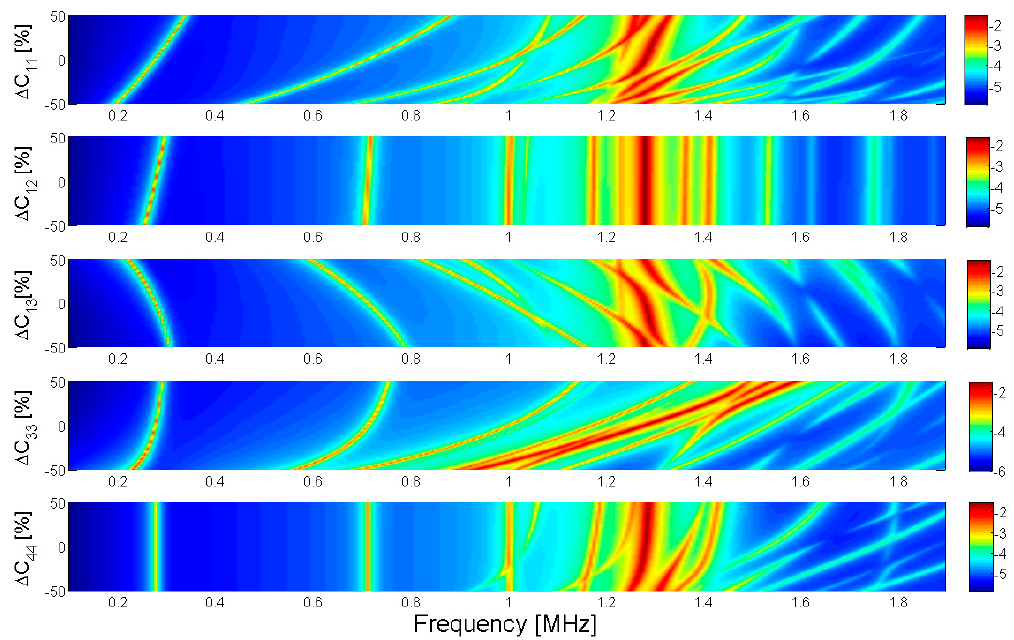
Figure 4. Sensitivity analysis for the real part of the elastic constants. Each curve shows the evolution of a resonance using the conductivity G. Each parameter is changed over a range ±50% from the initial value.